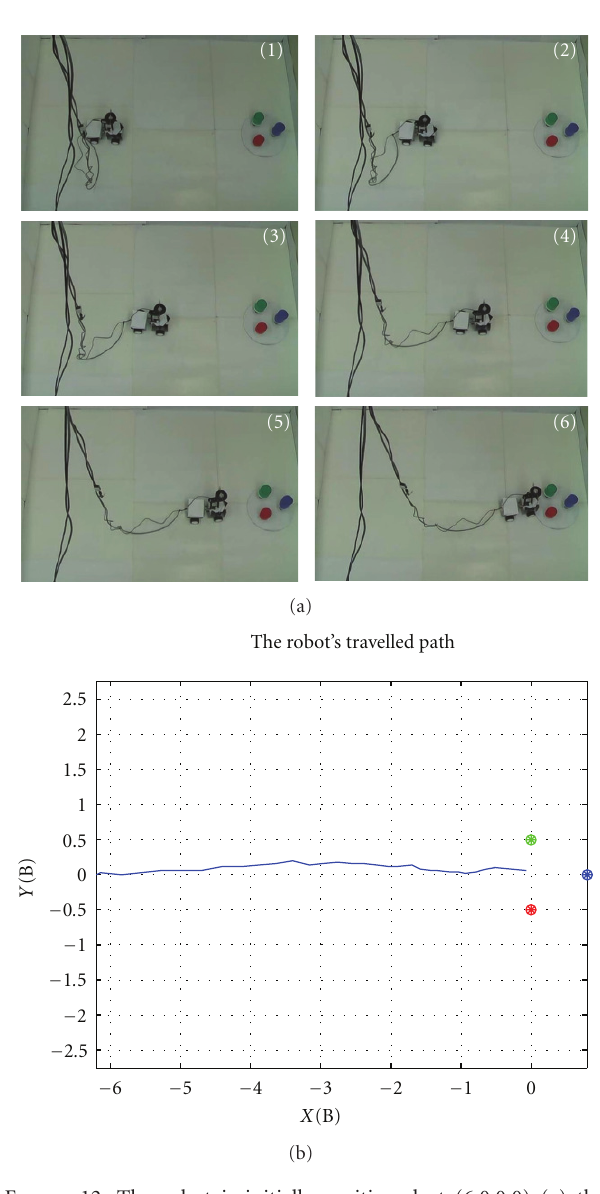
Figure 12: The robot is initially positioned at (6,0,0,0) (a) the snapshots of the experiment, (b) the traveled path of the